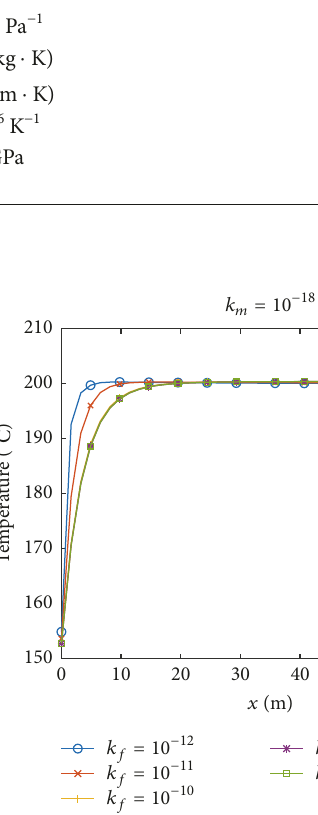
Figure6:Temperatureandthermalstressdistributionsafter30days of injection for a matrix permeability of 𝑘 𝑚 = 10 −18 m 2